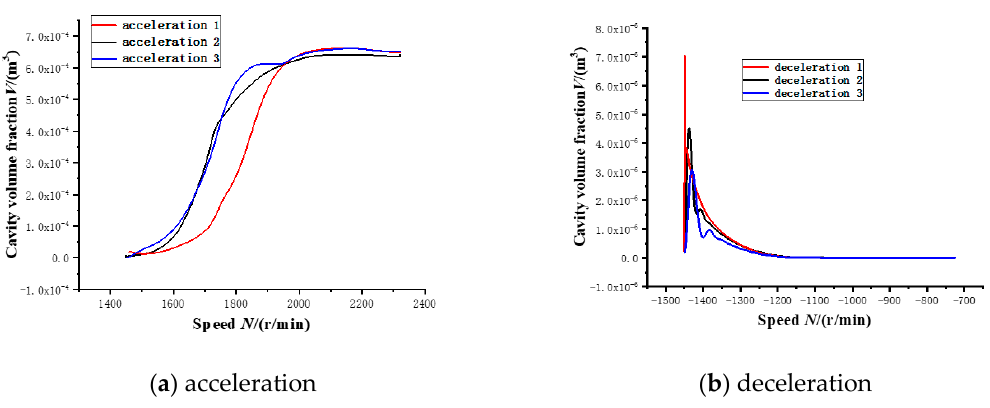
Figure 10. The average cavitation volume fraction in the impeller region.